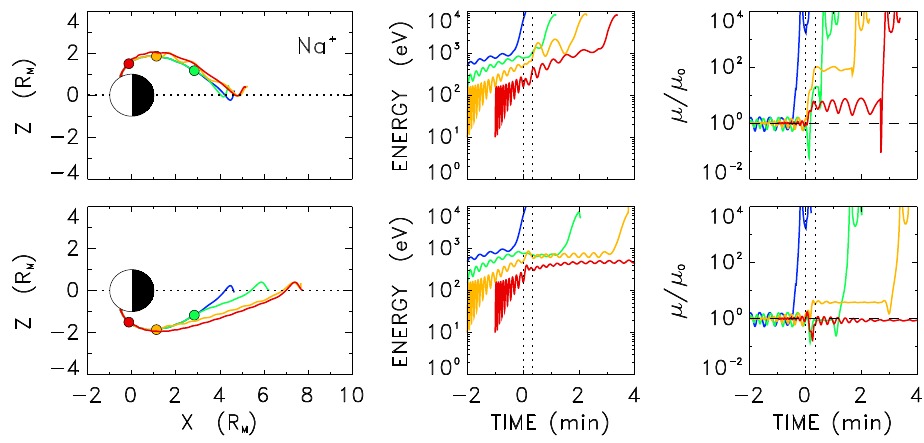
Fig. 8. Model Na + trajectories during a 20-s turning of the IMF from B X = 0 to B X = 20nT. The test ions are launched from the same location (60 ◦ latitude on the noon meridian) with 10eV energy and 30 ◦ pitch angle. Top and bottom panels relate to ions originating from Northern and Southern Hemispheres, respectively. (From left to right) Trajectory projections in the X-Z plane, energy, and magnetic moment (normalized to the initial value) as a function of time (measured from the onset of the IMF turning). The different colors correspond to distinct times of ejection (by steps of 1min). Color-coded closed circles in the left panels show the position of the particles at the onset of the IMF turning. Vertical dotted lines in the right panels delimit the 20-s magnetic transition.